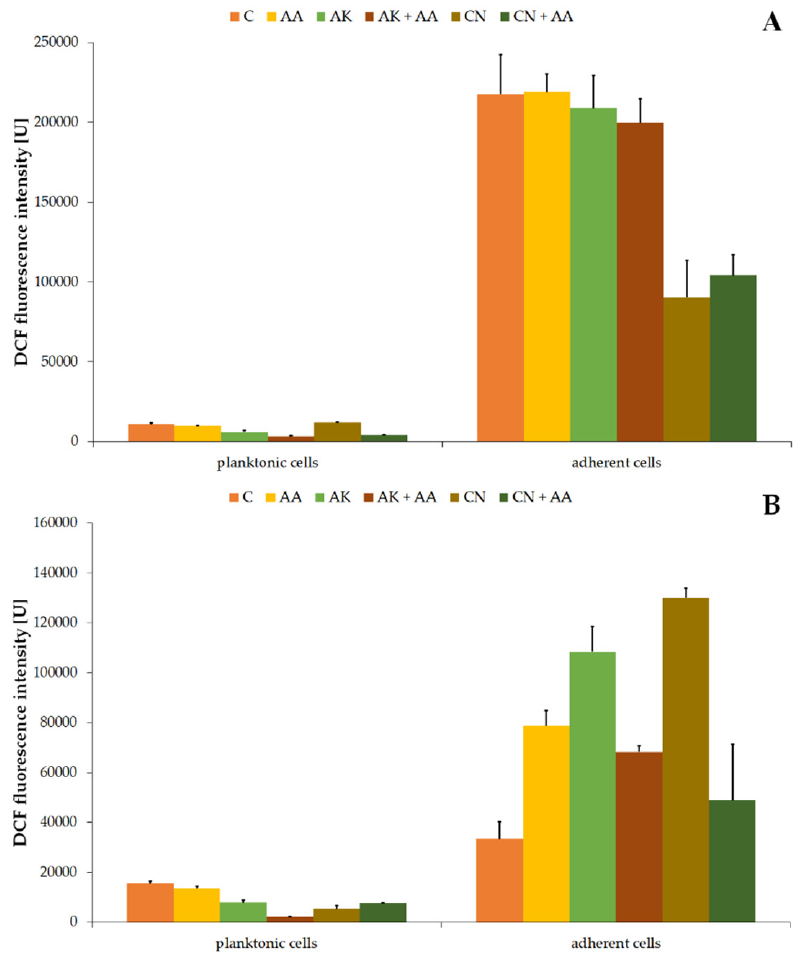
Figure 5. Changes of 2’,7’-dichlorofluorescein (DCF) fluorescence intensity in the planktonic and adherent cells of the ATCC 29906 ( A ) and C12 ( B ) strains treated with AA, AK, or CN. Legend: C—control, AA—ascorbic acid, AK—amikacin, CN—gentamicin. The values of DCF fluorescence intensity in the non-treated P. mirabilis planktonic cells were 10,929.97 U ± 797.14 U (Figure 5A) and 15,521.06 U ± 908.33 U (Figure 5B) for the ATCC 29906 and C12 strains, respectively. AA treatment had no significant effect on the hydroxyl radical level, while AK treatment limited its amount by at least 40%. The combined activity of amikacin and ascorbic acid lowered the DCF fluorescence intensity by at least 44%, compared to its value in the antibiotic monotherapy. On the other hand, the combined activity of gentamicin with ascorbic acid resulted in a 40% enhancement of the red fluorescence intensity in comparison to the drug